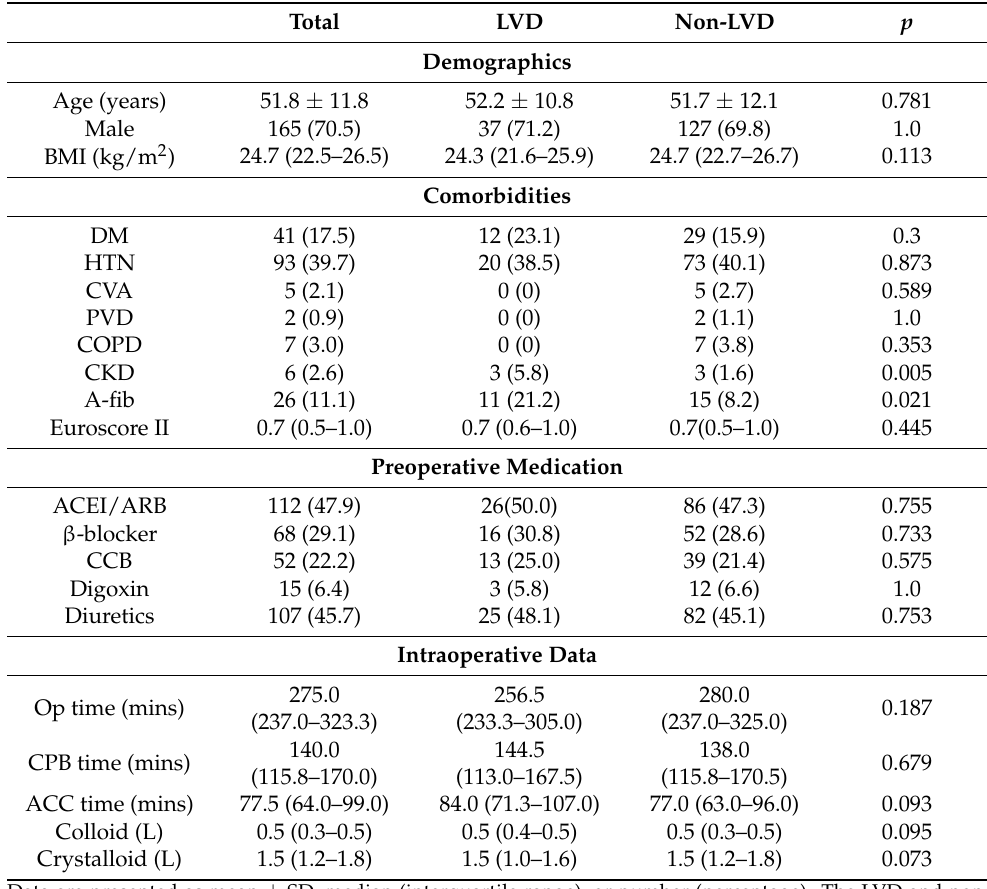
Table 1. Baseline